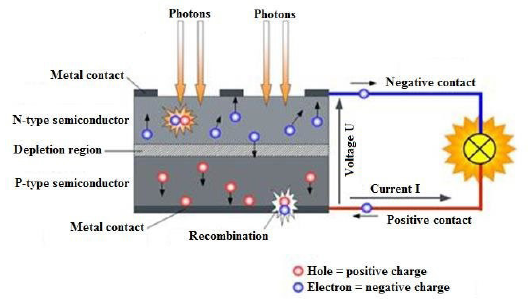
Figure 1. Construction and working of solar cell.